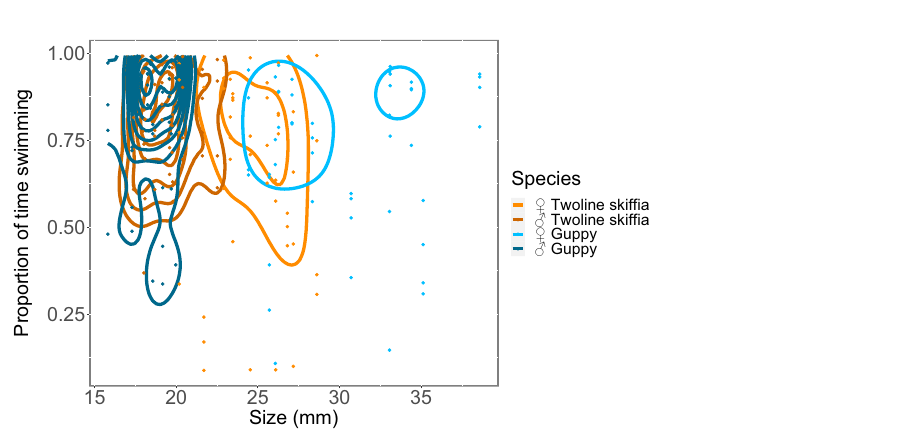
Figure 4. Proportion of the total time observed (600 s) fish of different sizes spent swimming around the aquarium. Lines represent the areas where data density is